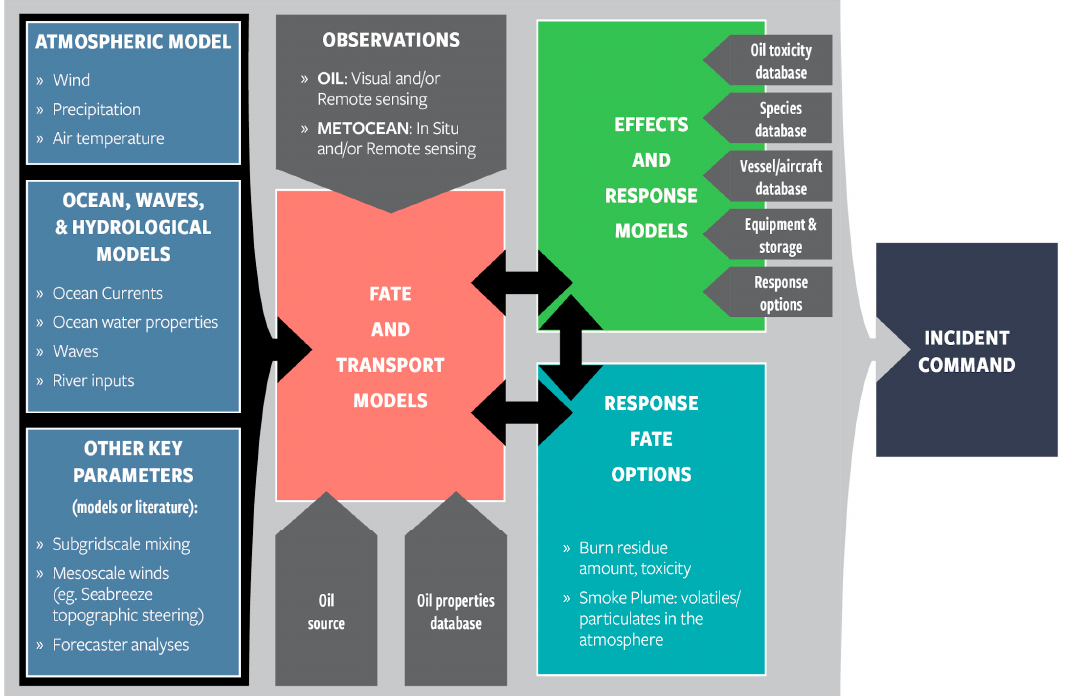
Figure 3. Schematic of the Operational oil spill modeling process.